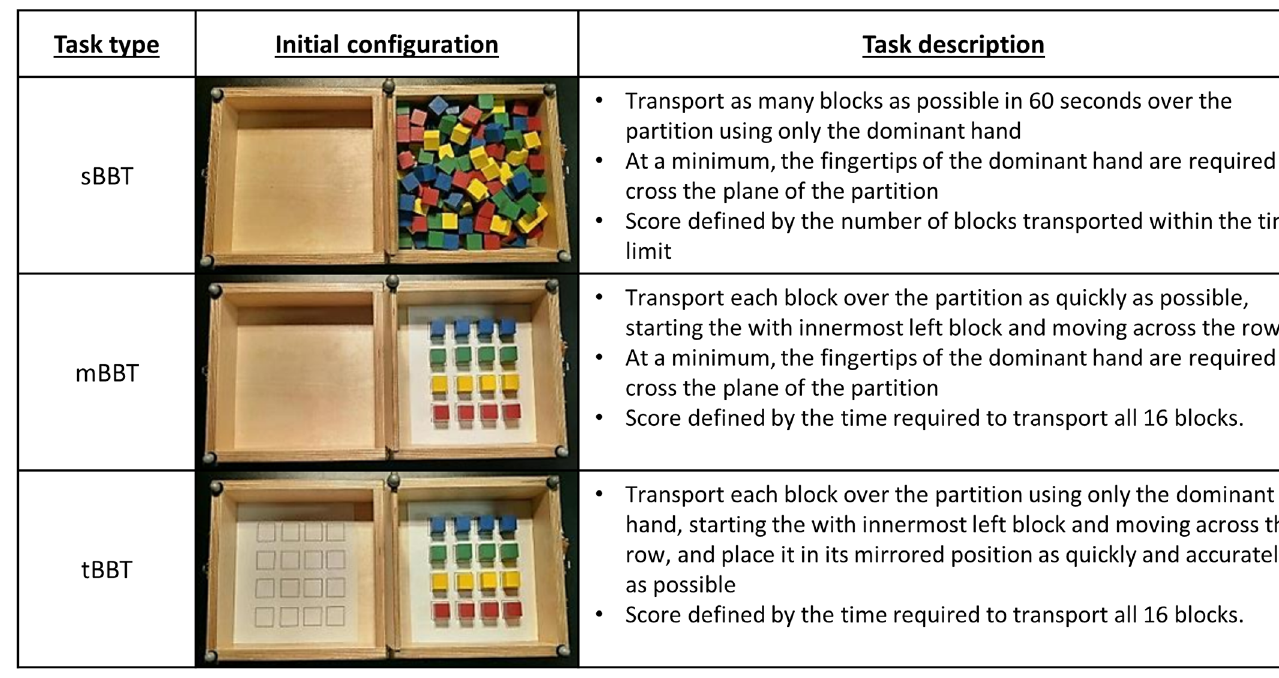
Fig 1. Description of